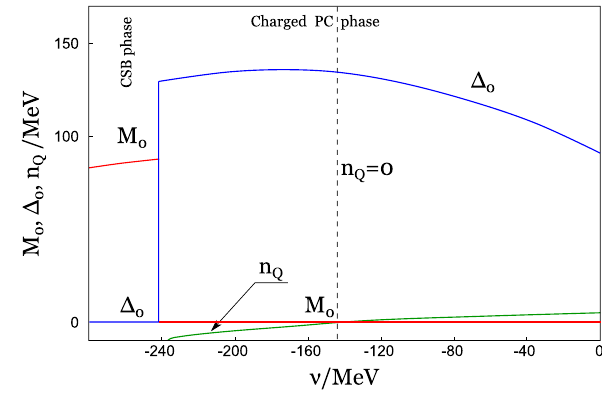
Fig. 13 The condensates (cid:4) 0 , M 0 and electric charge density n Q as a function of ν in the ground state of β -equilibrium quark matter at μ = ν = 400MeVand μ = 300MeVatthephysicalpoint, m 5 5 MeV. At ν < ν c ≈ − 235 MeV the condensates correspond to the CSB phase. At ν > ν c the charged PC phase of β -equilibrium matter is realized. Note that at the point ν 0 ≈ − 140 MeV we have n Q = 0. It means that at ν = ν 0 the β -equilibrium quark matter is electrically neutral and there the charged PC phase is realized